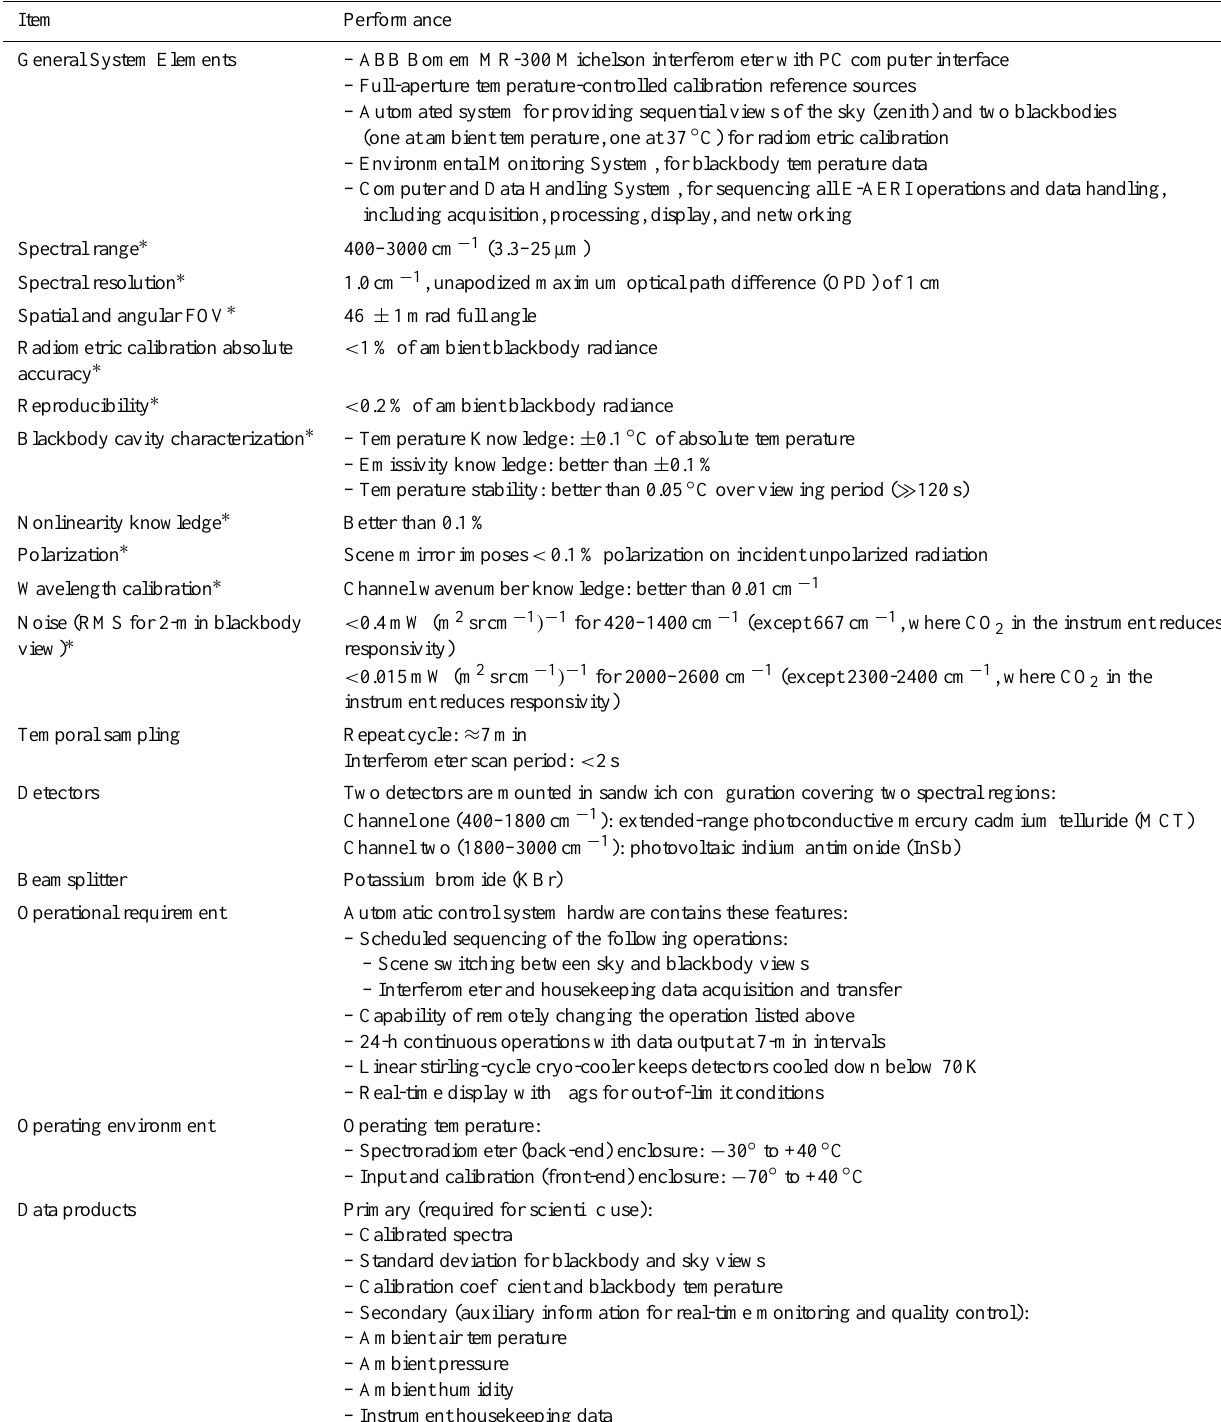
Table 2. E-AERI instrument